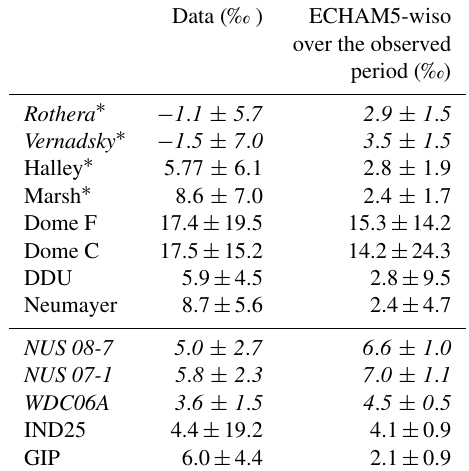
Table 7. Mean value ± standard deviation (in ‰) of sub-annual d in observational time series at daily or monthly scale (identified with an asterisk) for the precipitation and for the ice core data and simu- lated d by ECHAM5-wiso for the same time period as the observa- tions for precipitation and at the annual scale for the ice core. Mean values which are overestimated by ECHAM5-wiso are written in